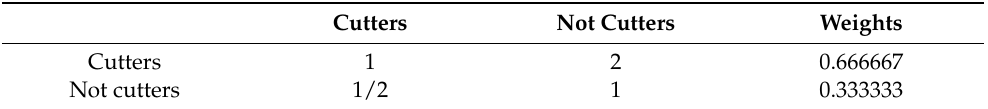
Table A1. Pairwise comparison matrix for tertiary level machinal factors (b2-c). λ max = 2; CR = 0; CI = 0.